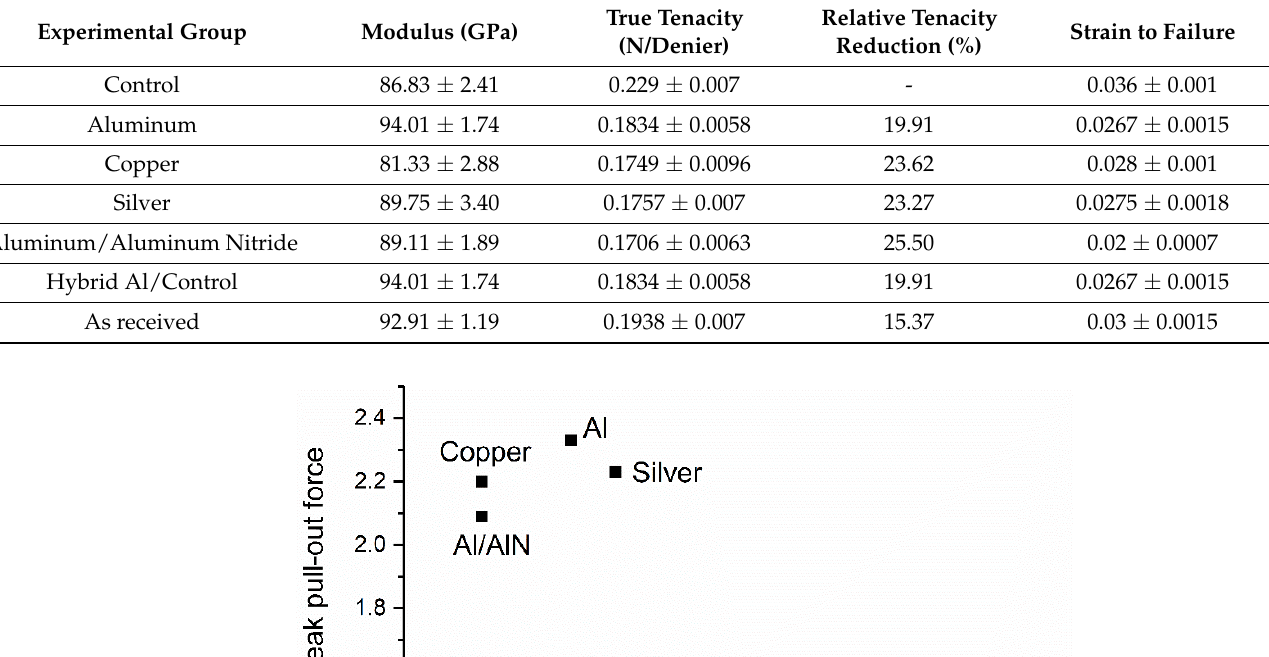
Table 5. Tensile modulus and tenacity of yarns. Tenacity reduction is calculated relative to the control yarn.